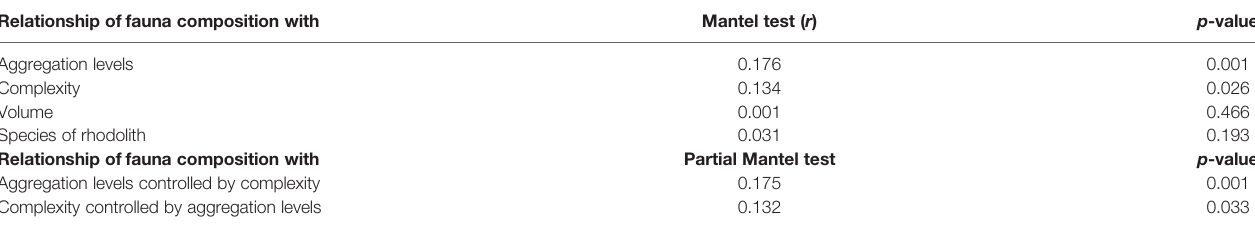
TABLE 9 | Mantel and partial Mantel test to determine the relationship of fauna and characteristics and aggregation of the rhodoliths (Isla del Coco). Relationship of fauna composition